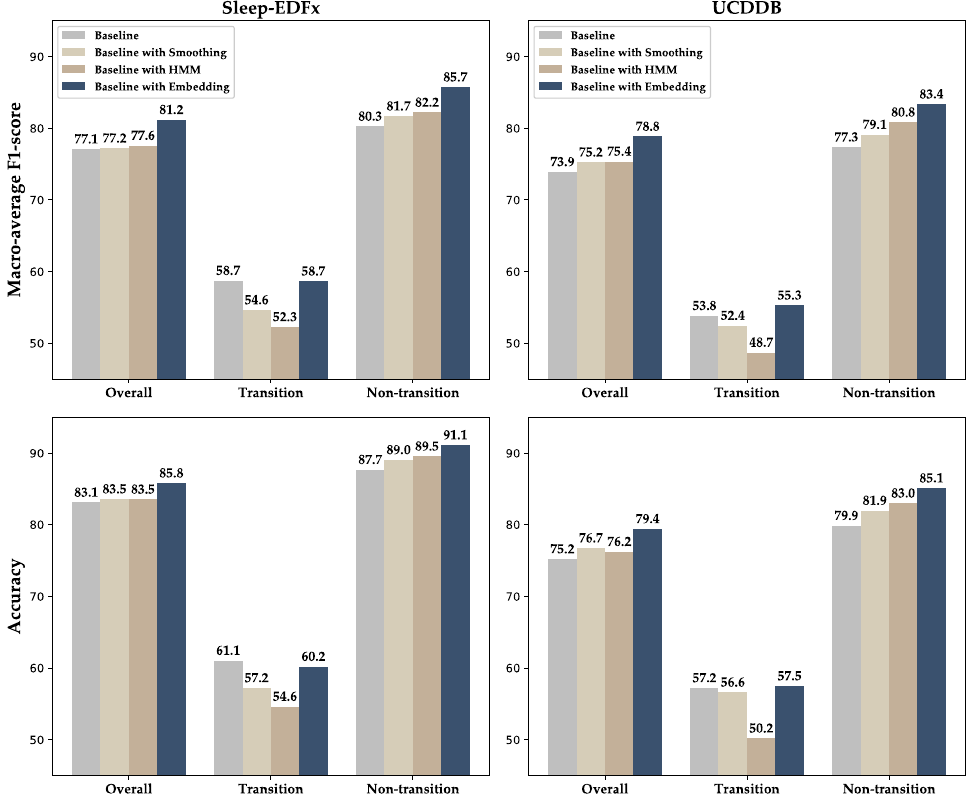
Figure 5. Performance comparison of di ff erent refinement methods on overall, transitional, and nontransitional epochs.